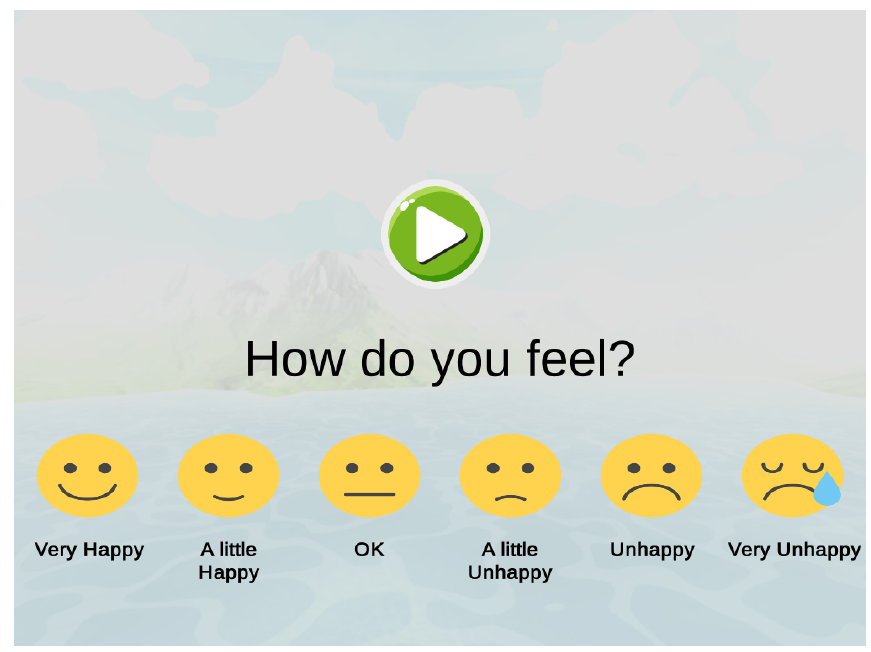
Figure 6. Audio interactive questionnaire. Table 2. Exposure hierarchy. Each exposure level corresponds to the distance between the participant and the virtual sound source; distance is represented in metres